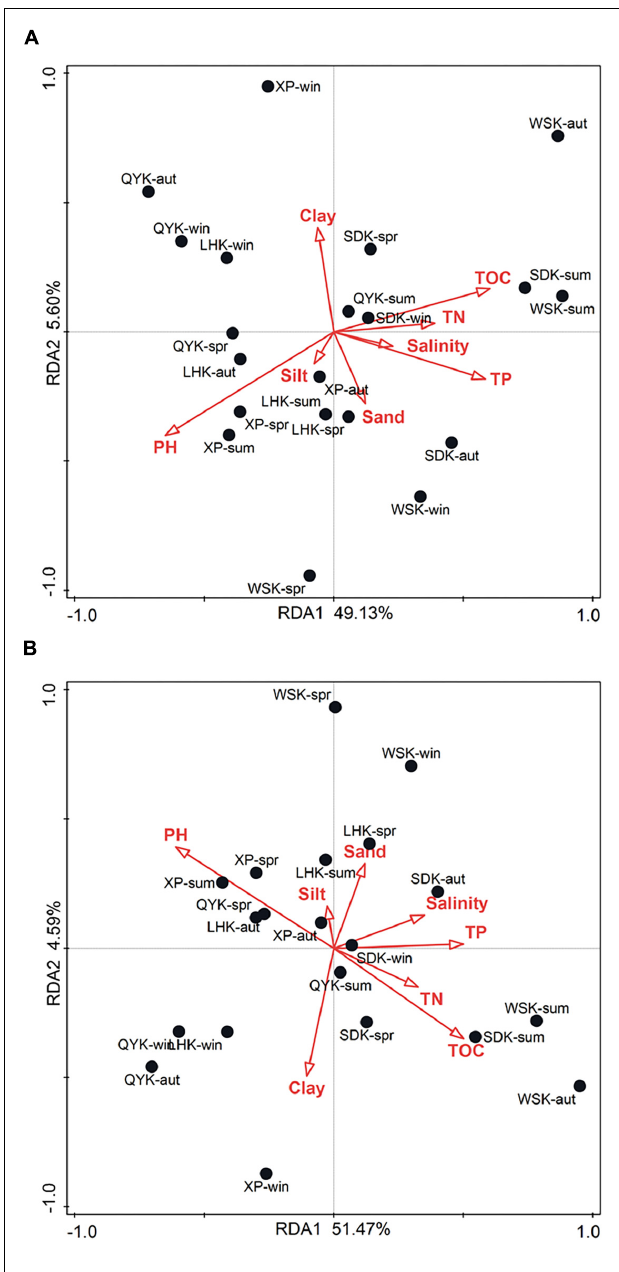
FIGURE 6 | Redundancy analysis (RDA) ordination plot of the composition and abundance of dominant bacterial (A) phyla and (B) classes in intertidal sediments of Yangtze River estuary, in relation to physicochemical properties of